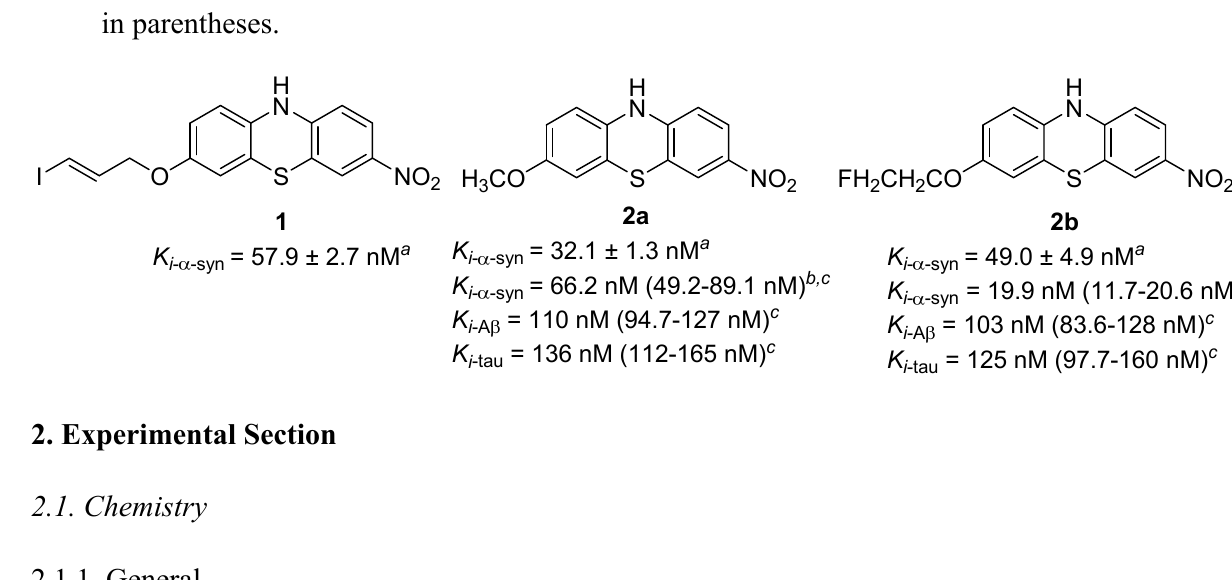
values are shown i